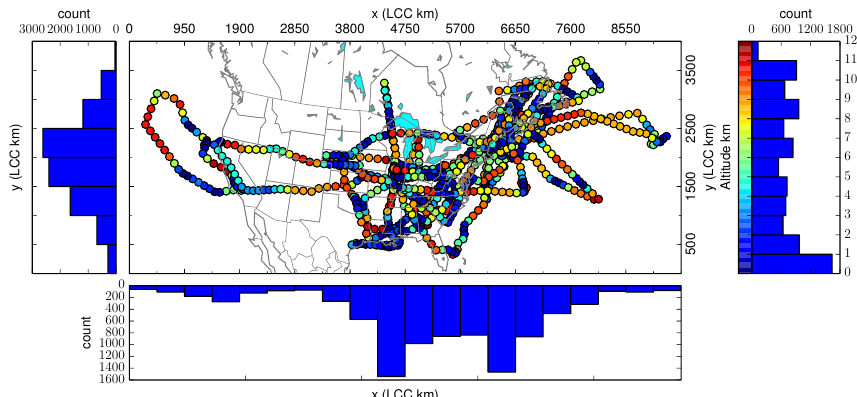
Figure 1. Sample locations (dots) from the INTEX-A campaign with altitude shown in color with histograms for latitude and longitude. The dots show every tenth sample, but the histograms use all